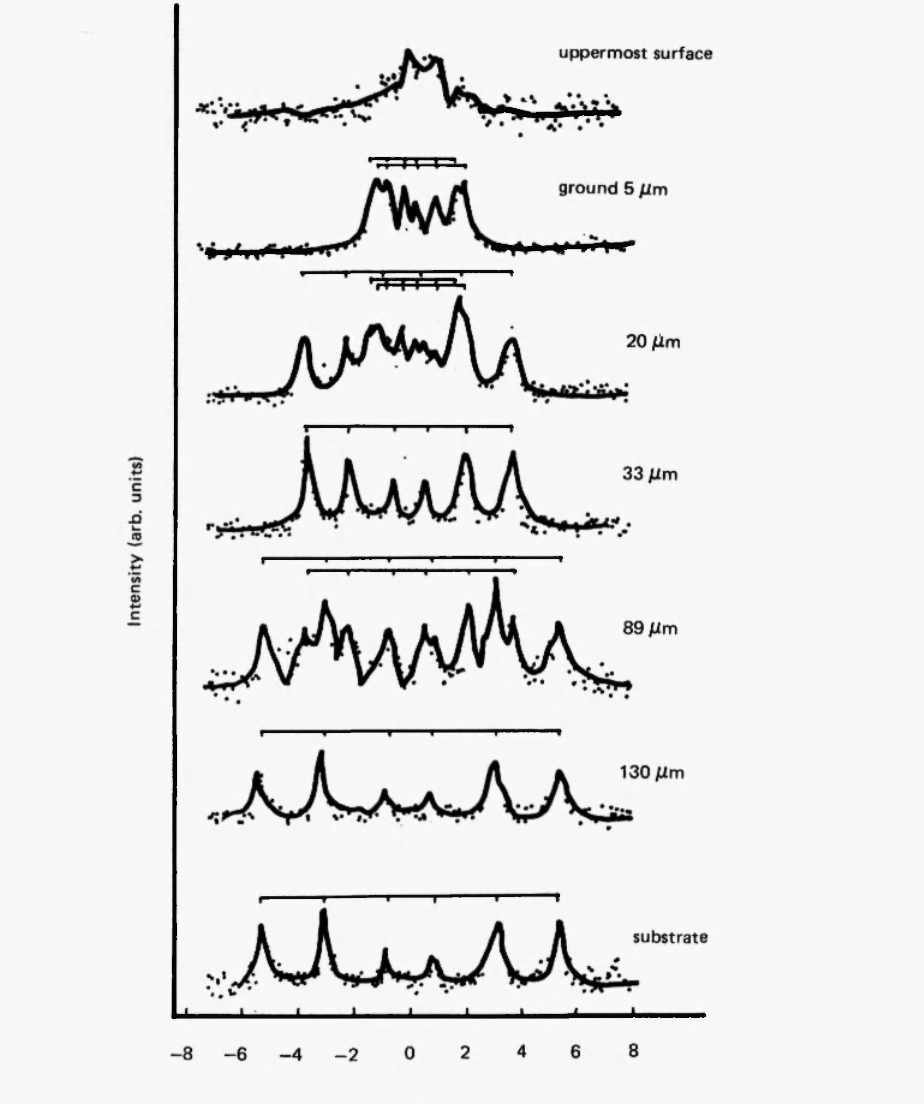
Fig. 22. CEM spectra of a borided steel surface observed after the removal of desired thickness by grinding with SiC powder (cited from ref.